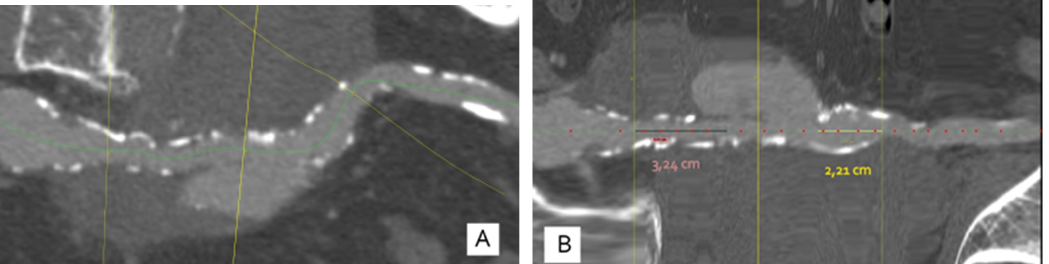
Figure 2. ( A )—Curved MPR reconstruction showing the vascular axis with the aneurysm surrounding the AIC, with a limited entrance gate (yellow line in the middle); ( B )—straightened reconstruction in the axis of the vessel (AIC); lines A and C represent the position of the bifurcation of the aorta and the bifurcation of the AIC, respectively, revealing the proximal landing zone at 32 mm and the distal landing zone at 22 mm.